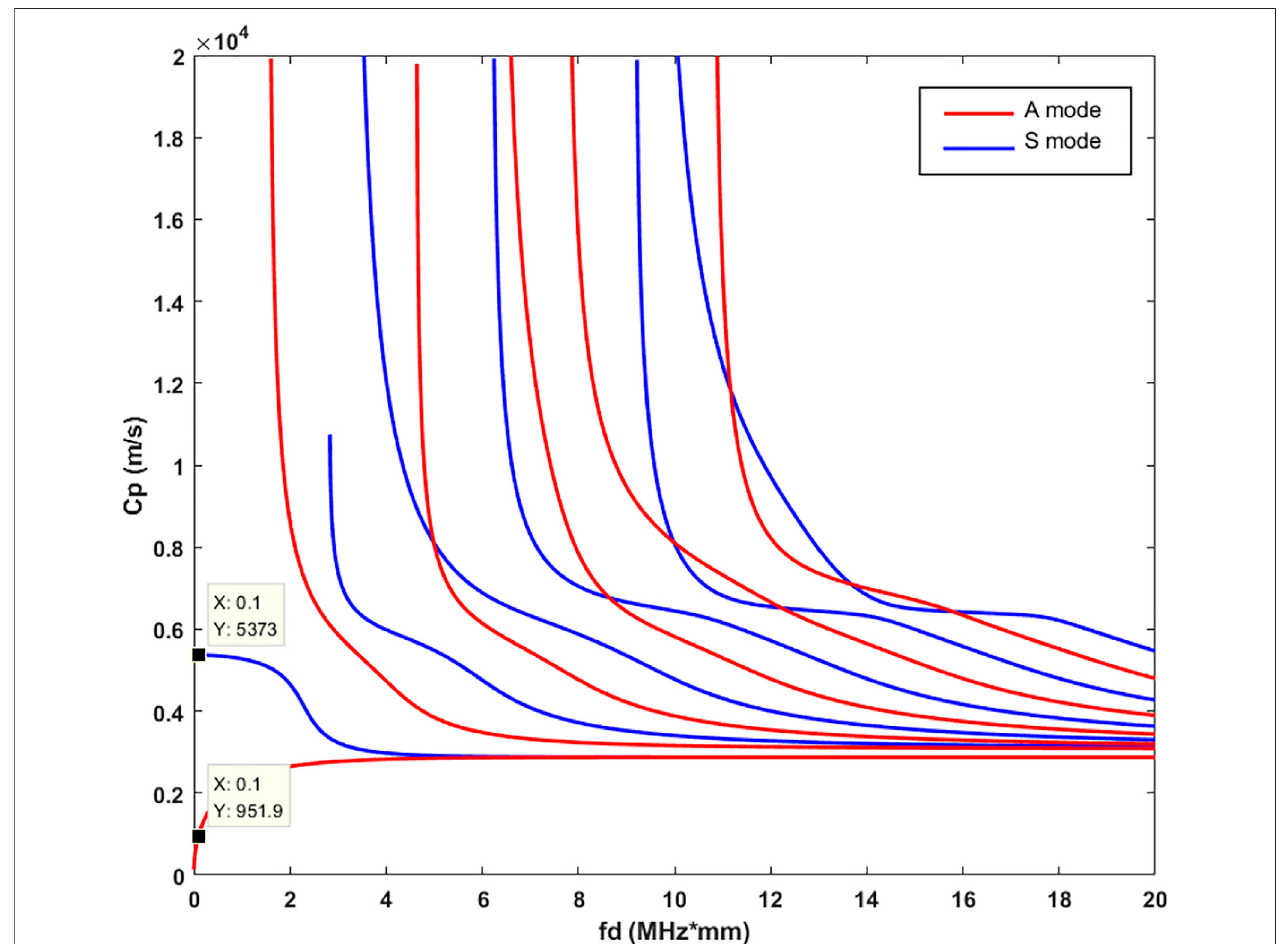
FIGURE 10 | Dispersion curve of aluminum